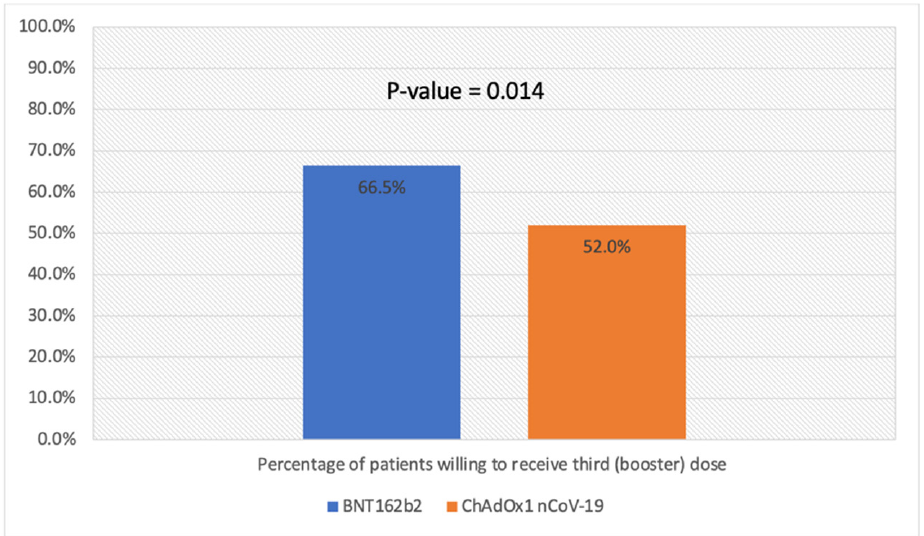
Figure 1. Percentage of patients willing to receive third (booster) dose stratified by type of previous vaccine.